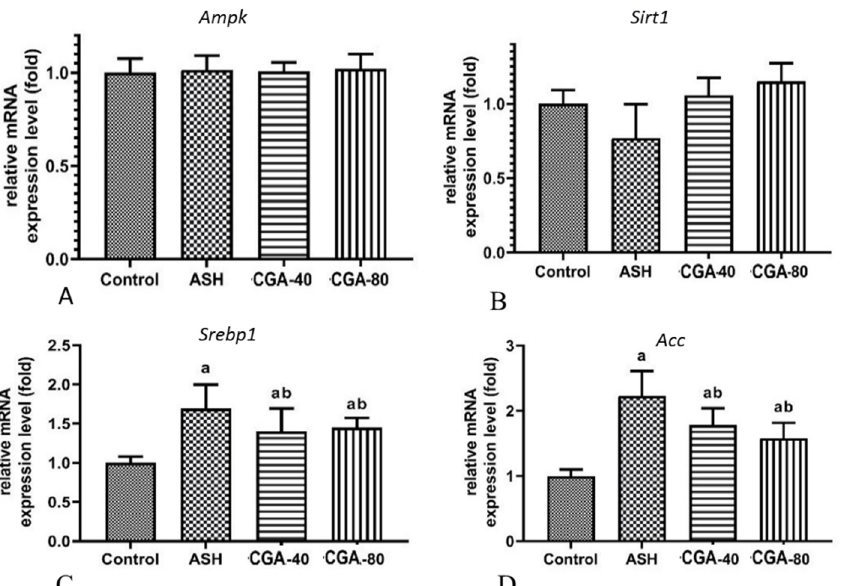
Figure 5. Effect of two CGA doses (40 and 80 mg/kg) on the expression of genes related to lipid metabolism in the liver of rats with alcoholic steatohepatitis (ASH) induced by chronic alcohol in- toxication. ( A )—Ampk α ; ( B )—Sirt1; ( C )—Srebp1; ( D )—Acc. M ± SD. a— p < 0.05 compared to the control group; b— p < 0.05 compared to the ethanol-administered